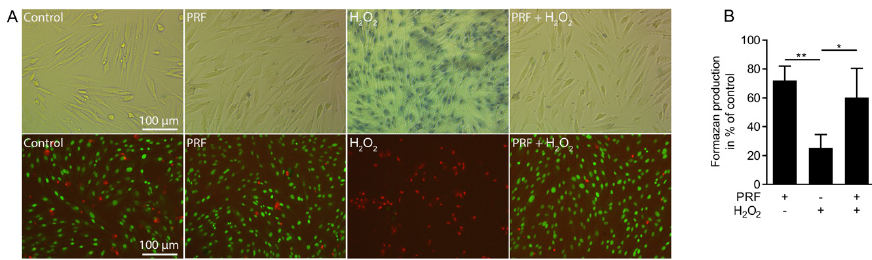
Figure 1. Platelet-rich fibrin (PRF) lysates rescue cells from acute hydrogen peroxide toxicity. Gingival fibroblasts ( A ) were exposed to 10% PRF lysates in the presence or absence of 3 mM H 2 O 2 for 3 h. Necrotic cell death is shown by the uptake of trypan blue that however was not observed in the presence of PRF lysate. Live-dead staining was performed in gingival fibroblasts with viable cells appearing in green and dead cells in red. ( B ) Cell viability is represented by formazan production